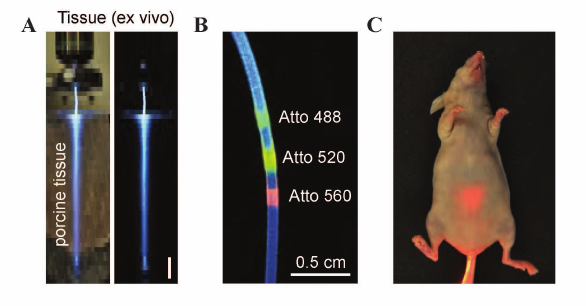
Fig. 7. Hydrogel-based optical waveguide. (A) Light guidance of a fiber in a tissue ex vivo . Scale bar, 1 cm. (B) A fluorescence image of a fiber doped with three different fluorophores along the fiber, as indicated. (C) In vivo light guidance through a hydrogel fiber admin- istered to the colon through the rectum. Reprinted by permission from [43], Copyright 2015,